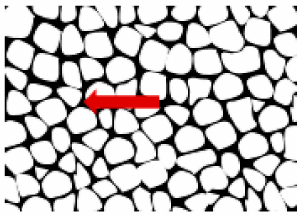
Figure 5. The model ferrite grain formed during grinding. The wall with high dislocation density is depicted by the arrow.